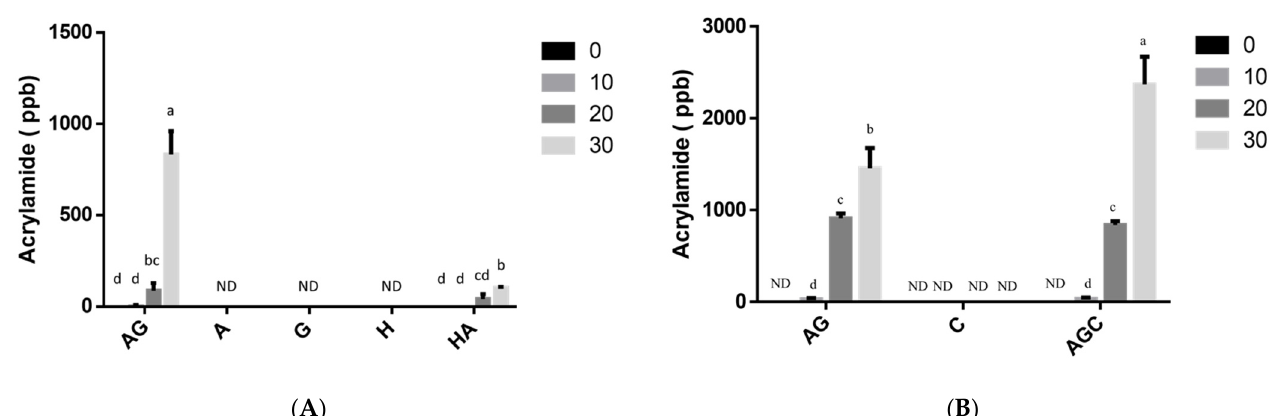
Figure 3. Amounts of acrylamide (ppb) between different groups in: ( A ) deionized water and ( B ) acetic acid at various heated processing duration. AG: asparagine + glucose; A: asparagine; G: glucose; H: hydroxymethylfurfural; HA: hydroxymethylfurfural + asparagine; C: chitosan; AGC: asparagine + glucose + chitosan. ND: Not Detected. Values are expressed as mean ± standard deviation (SD) (n = 3). a–d Indicate significant differences between different groups ( p < 0.05).